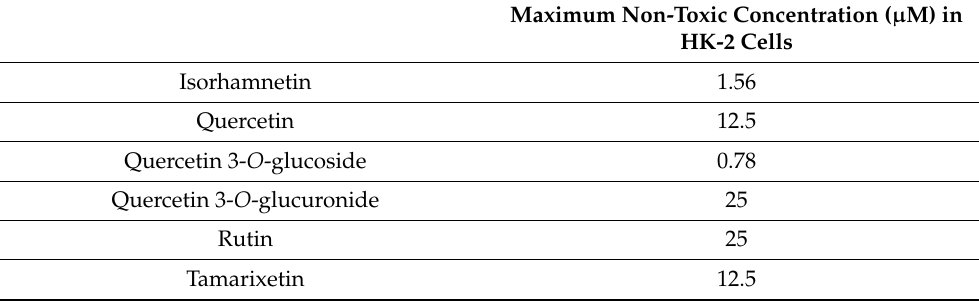
Table 1. Higher non-toxic concentrations of quercetin metabolites in HK-2 cells. The data were obtained by cell viability tests (MTT assay; Figure S1, Supplementary